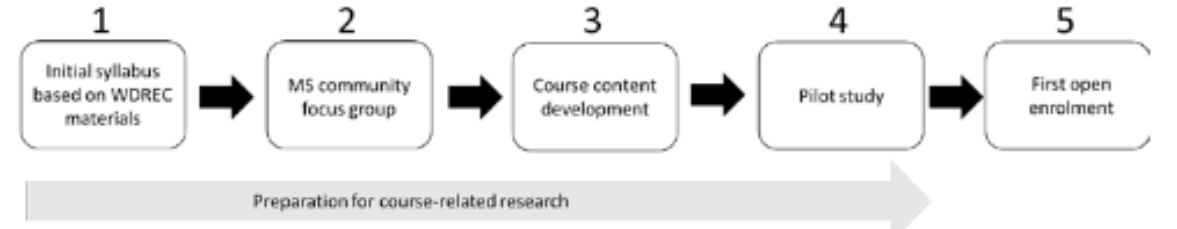
Figure 1. Course development flowchart. MS: multiple sclerosis; WDREC: Wicking Center for Dementia Research and